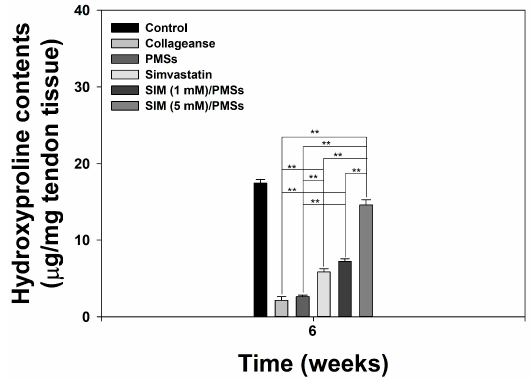
Figure 6. Hydroxyproline contents in Achilles tendon tissues from collagenase-induced Achilles tendinitis rat models 6 weeks after treatment with PMSs, simvastatin, SIM (1 mM)/PMSs, and SIM (5 mM)/PMSs. Data represent means ± SDs ( n = 4), (** p < 0.01).